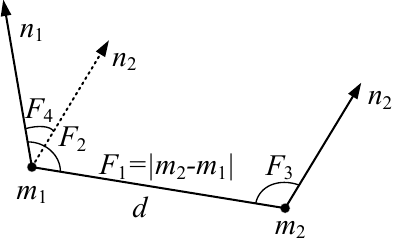
Figure 5. Schematic diagram of point pair features.